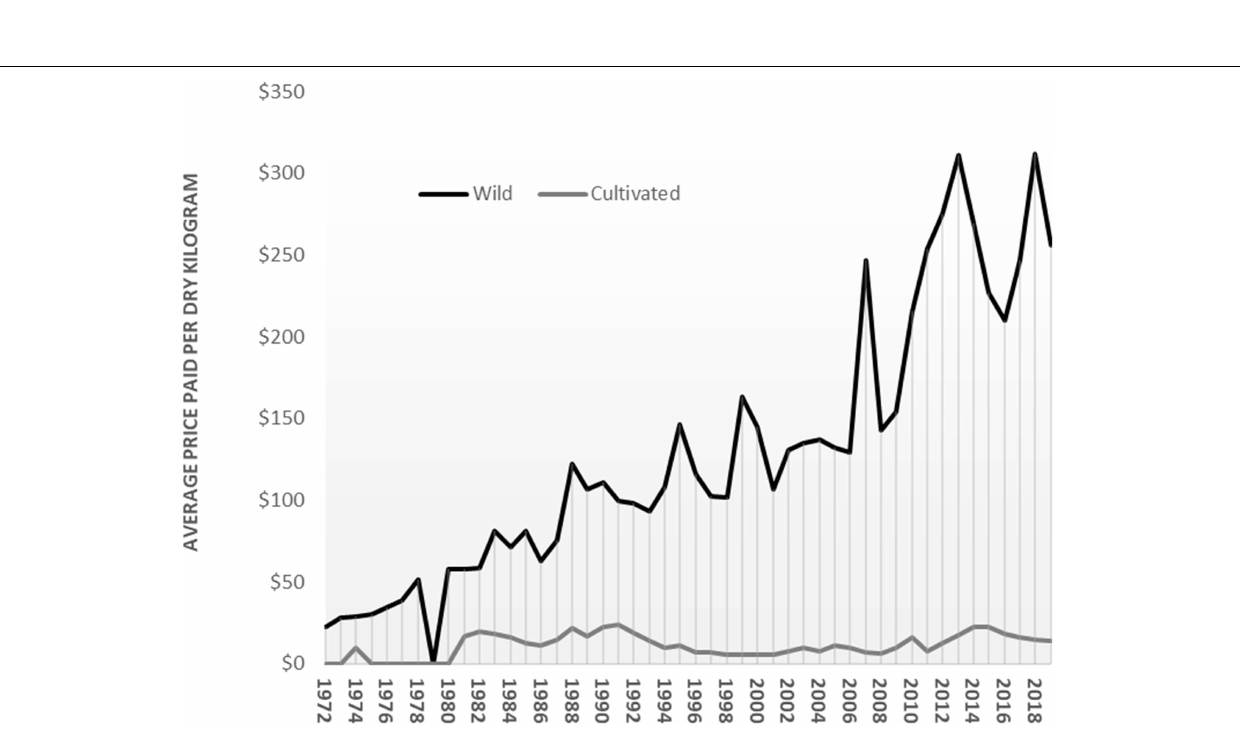
Frontiers in Ecology and Evolution |